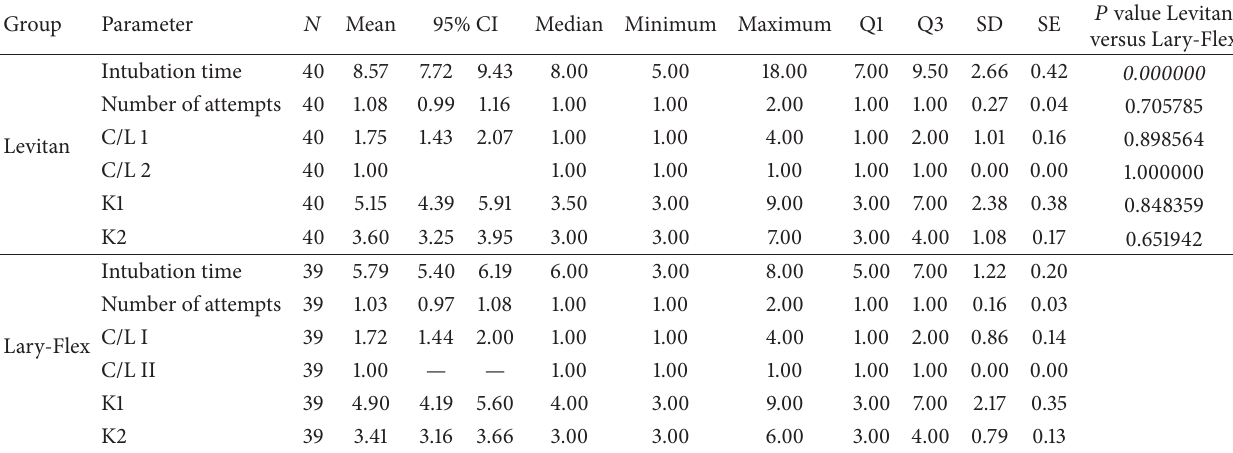
Table 4: Evaluation of intubation conditions data of studied groups.